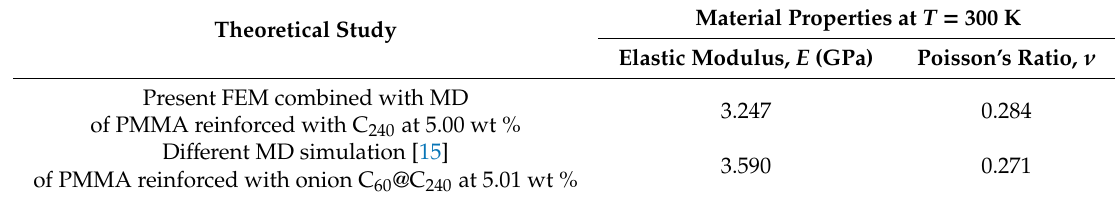
Table 3. Present elastic properties of the nanocomposite with w C240 = 0.05 in contrast with some comparable results from another theoretical study.